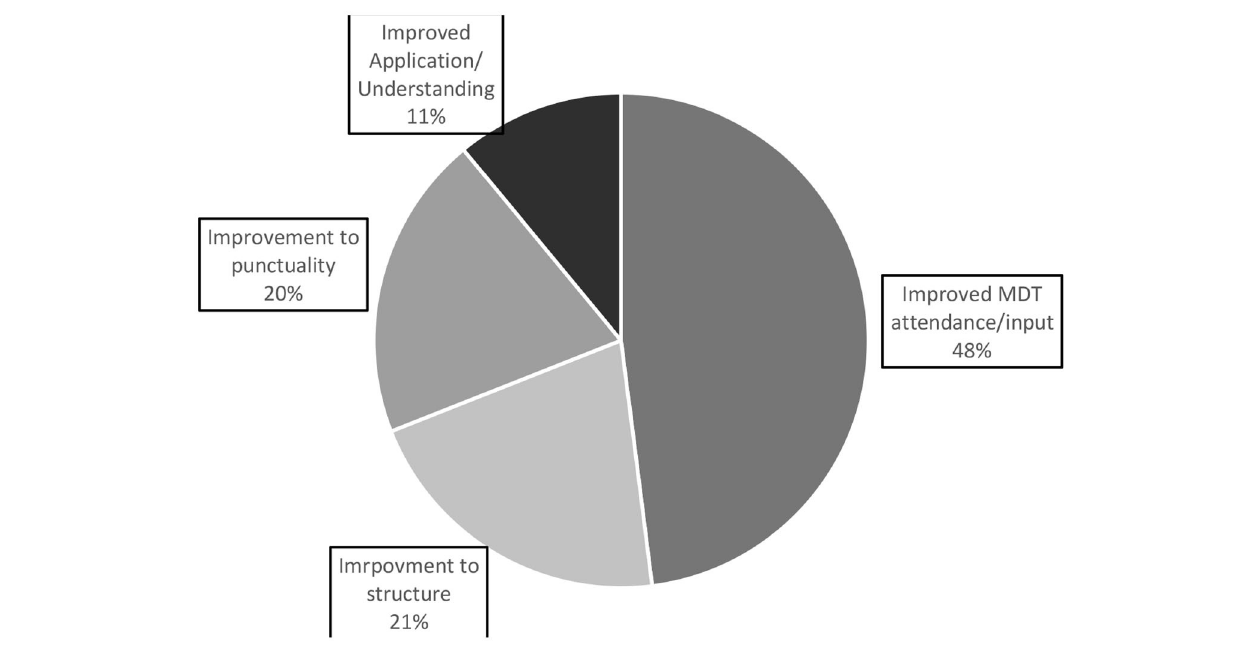
FIGURE 3 | A pie chart representing the overall themes of responses to question 3 “what could be improved in the huddle?”.